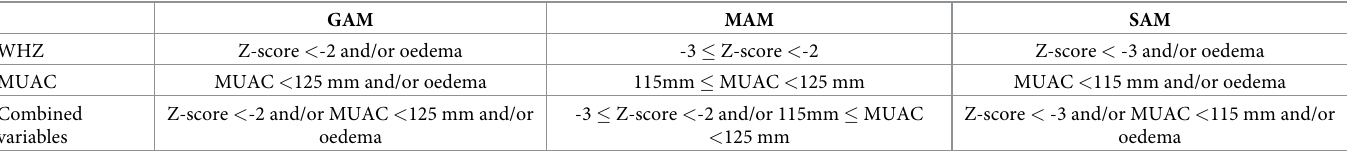
Table 1. Acute malnutrition criteria and